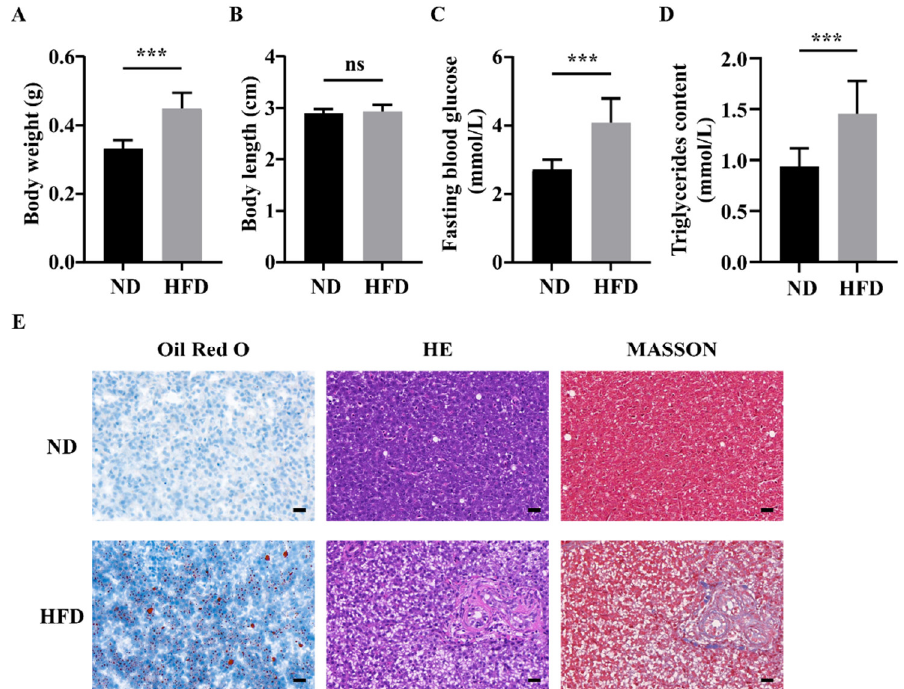
Figure 1. Long-term high-fat diet (HFD) feeding induced obesity and liver injury in zebrafish. ( A ) Body weight of zebrafish. ( B ) Body length of zebrafish. ( C ) Fasting blood glucose of zebrafish. ( D ) Muscle triglyceride contents. ( E ) Oil Red O staining, H&E staining, and Masson staining of zebrafish livers. ***, p < 0.001. Data represent means, and error bars represent standard errors of the means. Scale bar, 20 µ m. ND, normal diet; HFD, high-fat